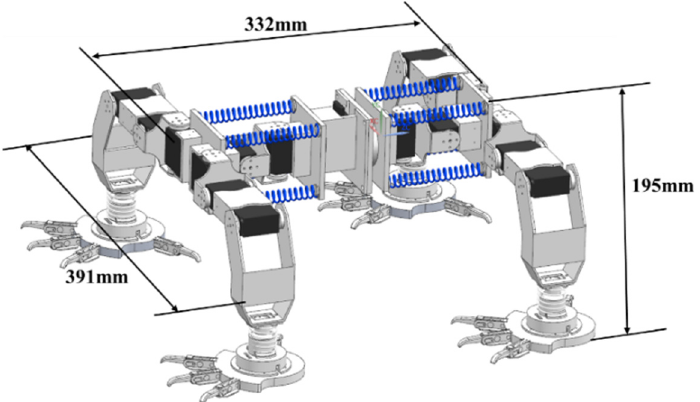
Figure 3. Structure of quadruped robot inspired by desert chameleon.